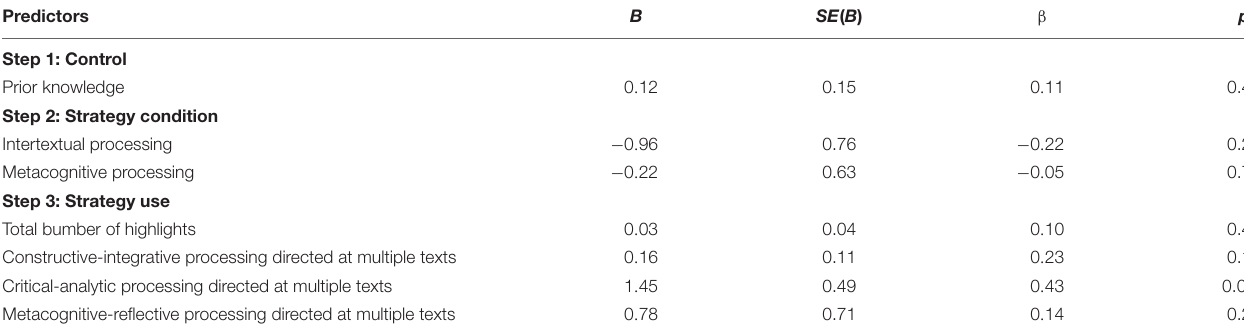
TABLE 7 | Model summary predicting open-ended integration performance.